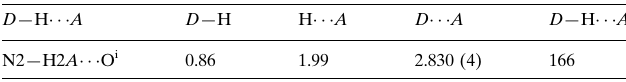
Hydrogen-bond geometry (A˚ , (cid:2)